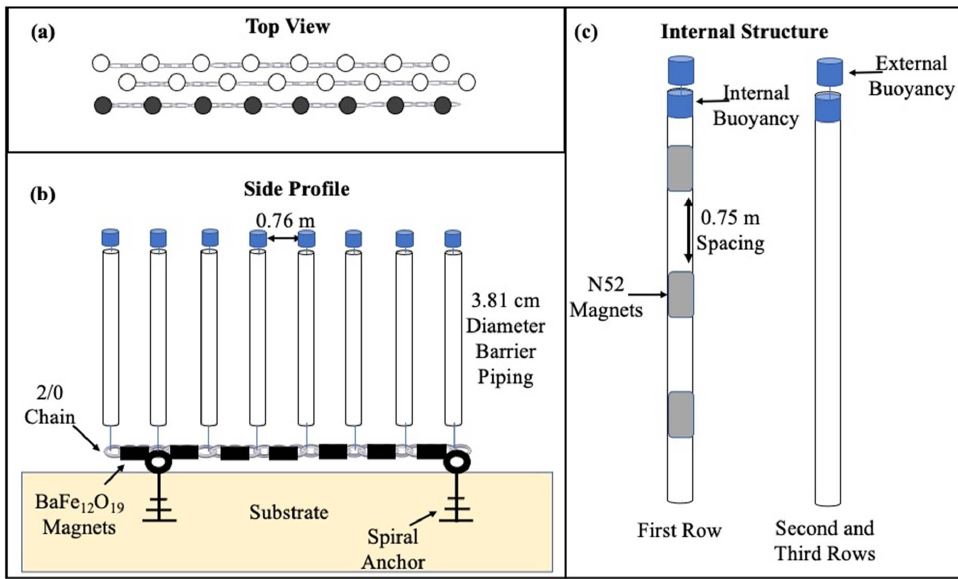
Figure 3. Sharksafe barrier experimental setup. ( a ) Top view. The barrier was composed of three, 25 m long alternating rows of barrier piping. The outer row consisted of piping equipped with equally spaced 3.2 cm × 2.54 cm N52 Neodymium (Nd 2 Fe 14 B) disc magnets (i.e., black circles), whereas the two inner rows of piping contained unmanipulated piping (i.e., white circles). ( b ) Side profile of the outer row of piping. Pipes were 1 to 3 m long and 3.81 cm in diameter and were separated by 0.76 m. Pipes were connected to the seafloor using a flexible heavy duty 2/0 chain. Located between adjacent pipes and along the chain was a 15.2 cm × 10.2 cm × 5.1 cm grade C8 BaFe 12 O 19 permanent